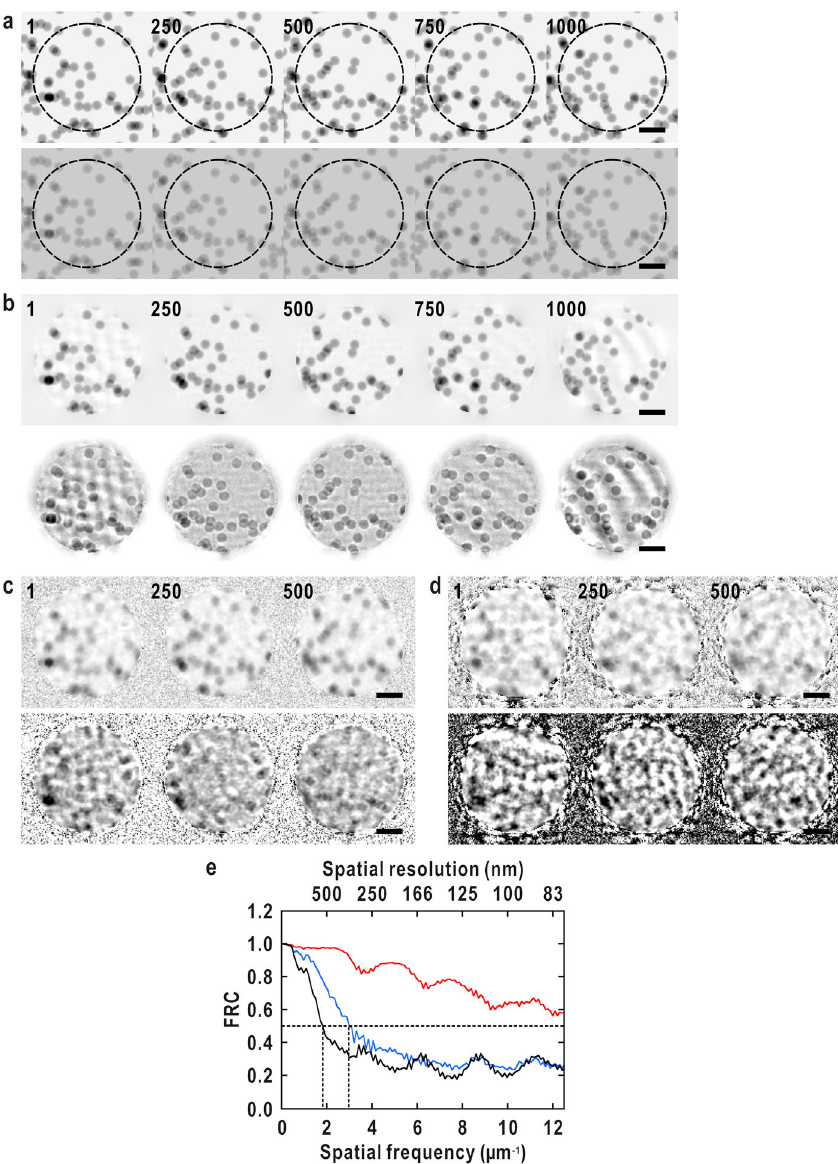
Fig. 5 Numerical demonstration of multiple-shot coherent diffraction imaging. a Selected frames of the model at glycerine concentration of 90%w/v and temperature of 283 K. Phase (upper) and absorption (lower) images of the object transmission functions averaged over the frame time are shown. The illuminated area is indicated with the broken circles. Phase (upper) and absorption (lower) contrast object frames reconstructed using b multiple-frame ptychographic iterative engine with total-variation regularisation (mf-PIE-TV), c mf-PIE, and d extended PIE (ePIE). e Temporal-averaged Fourier ring correlation (FRC) curves for mf-PIE-TV (red), mf-PIE (blue), and ePIE (black). The broken line indicates a threshold of 0.5 and corresponding spatial frequency. The grayscale is the same as that shown in Fig. 4. The frame numbers are indicated in the phase images. Scale bars indicate 1 μ